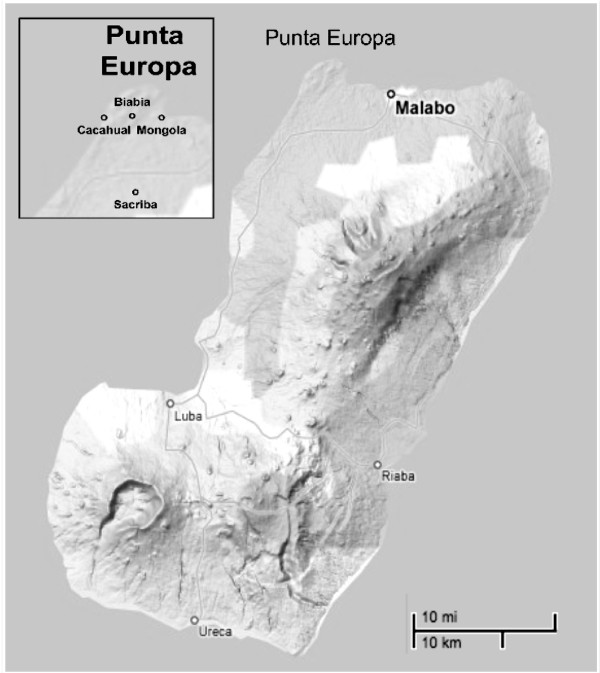
Map of study villages in Punta Europa, Bioko Island, Equatorial Guinea. Also indicated is Sacriba, the location of the collections made by Molina et al [5].